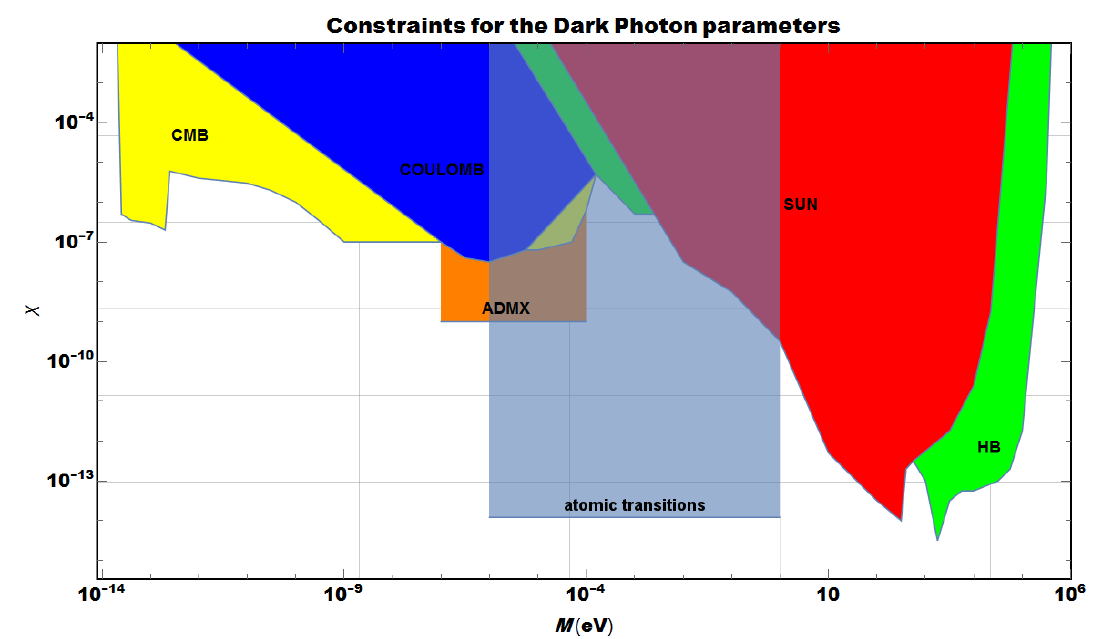
Figure 3 . Expected sensitivity of the proposed detector for the coupling of the DP to electrons (shaded region), estimated at 95% C.L. under the assumptions spelled out in the text. It is compared with present constraints from other analyses, in particular the other colored regions show the bounds imposed by solar (red) and horizontal branch stars (green) studies, Coulomb law (blue) and CMB (yellow) tests, and the limits that can be achieved by the ADMX experiment